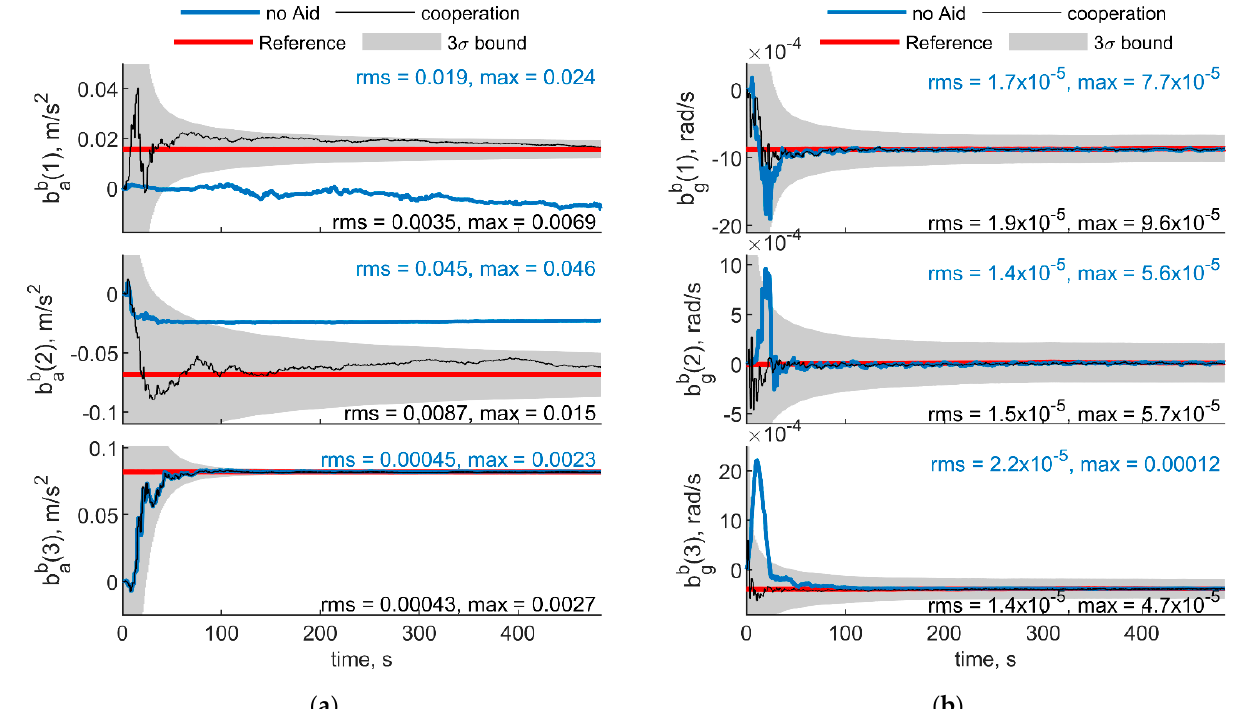
Figure 7. ( a ) Accelerometer and ( b ) gyroscope biases predicted by the filter. Chief trajectory is reported in Figure 3. Two deputies, r = 100 m, μ = 0°, Δχ = 20°. Reference value is reported in red. Results obtained with cooperation and without cooperation have been reported in black and blue, respectively. RMS and maximum error value have been evaluated starting from t = 60 s.